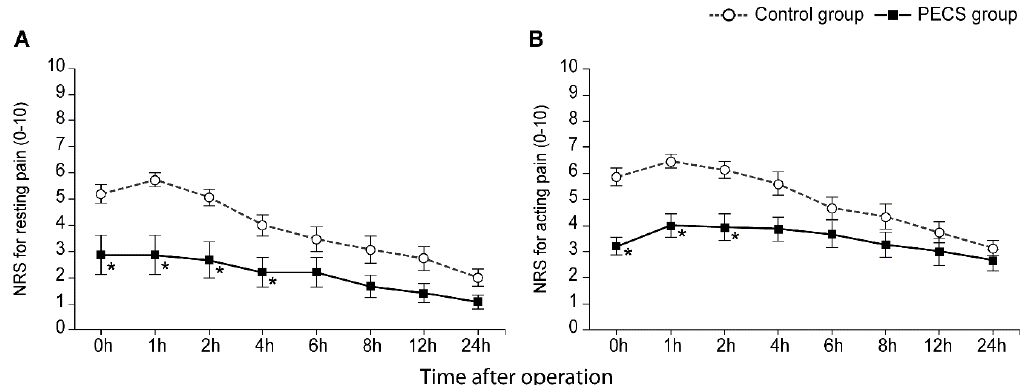
Figure 3. Numerical rating scale for resting ( A ) and acting ( B ) pain intensity during 24 h after operation. Values are presented as mean ± standard error. PECS, pectoralis nerve II block; NRS, numerical rating scale. * Bonferroni corrected p < 0.05 versus the control group.